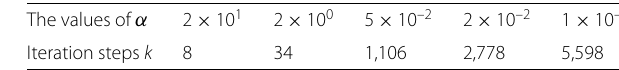
Table 1 The comparison of iteration steps k with different α for Example